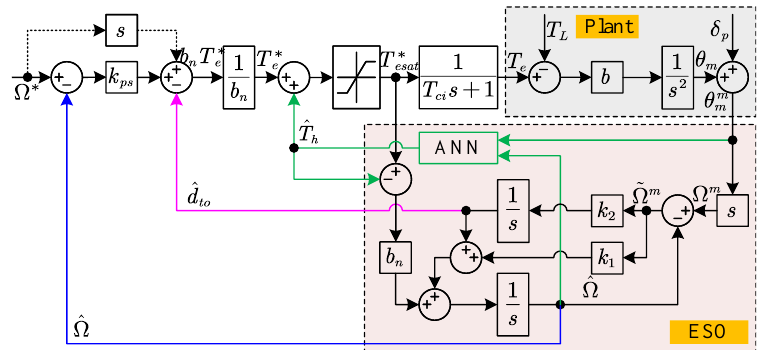
Figure 3. Block diagram of the NN-ESO-ADRC with double